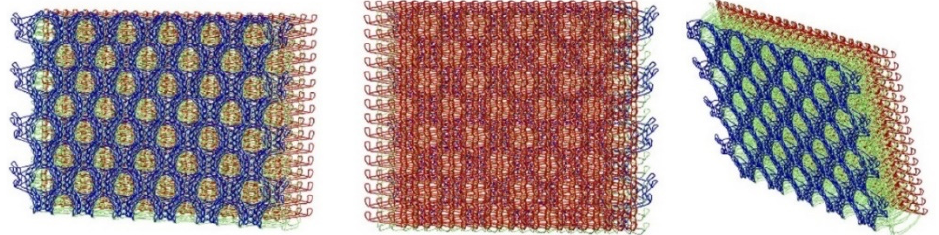
Figure 4. The visualization of spacer knitted fabric (I) designed in ProCad Warpkni. For each of the knitted fabrics, photographs of the right and left sides were taken using OPTA-TECH’s X2000 stereoscopic microscope (Warsaw, Poland). For the 3D fabric, cross-sectional photos were also taken (Figure 5).